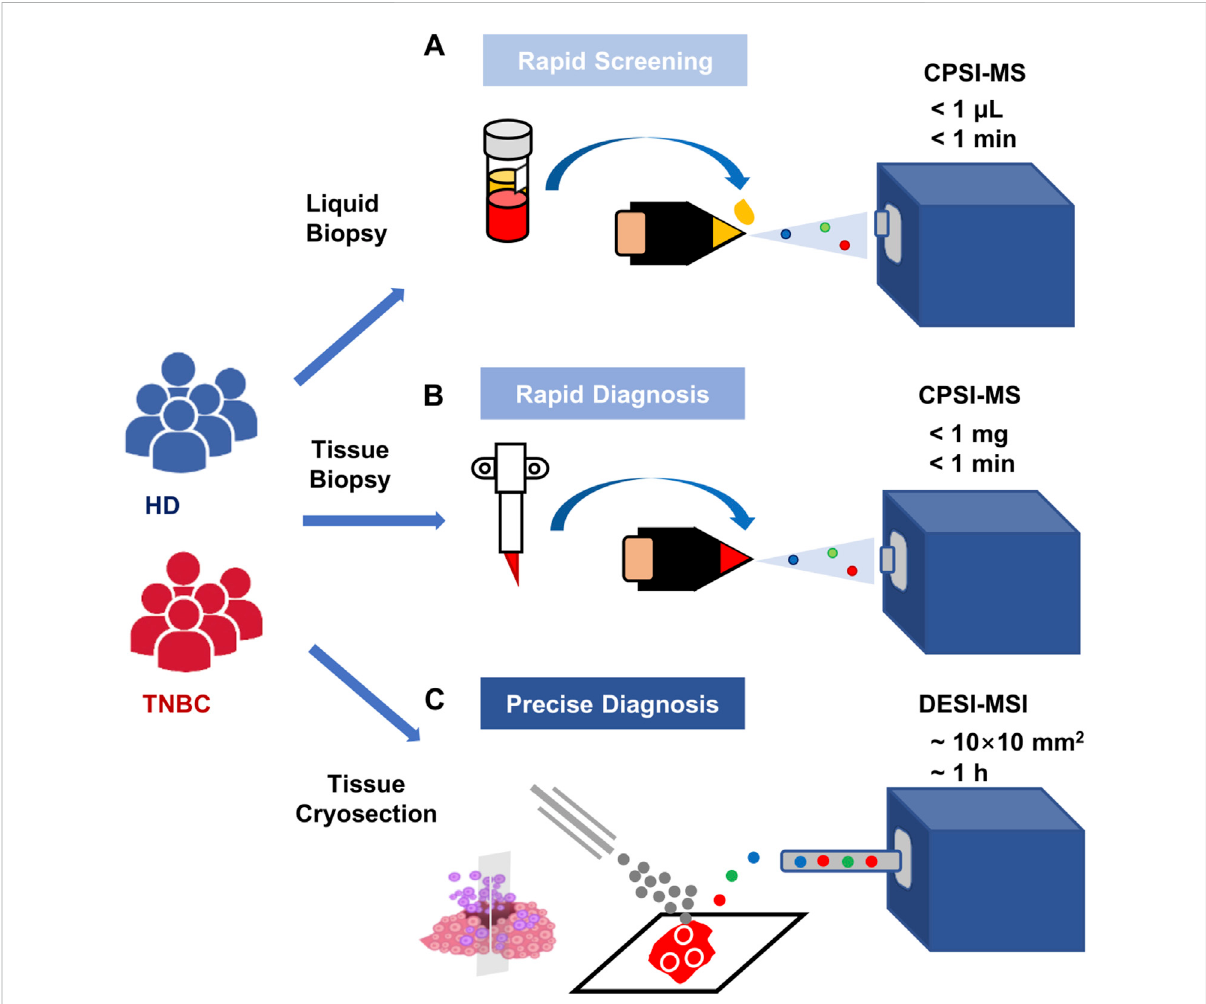
FIGURE 5 Recommended scenarios for CPSI-MS in clinical application for TNBC screening and diagnosis. (A) The high-risk population screening conductedbyCPSI-MSonlyconsumes1 μ Lserumcollectedfromeachclinicalrecipientandtakeslessthan1 mintocompletemetabolicpro fi ledata acquisition; (B) the metabolic pro fi ling and rapid TNBC diagnosis conducted by CPSI-MS only consumes trace amount of biopsied tissue (less than 1 mg) from these highly suspicious patients; (C) more precise diagnosis and spatially resolved metabolic pro fi ling is conducted by DESI-MSI accompanied with molecular pathology on these patients who receive surgical resection of the TNBC